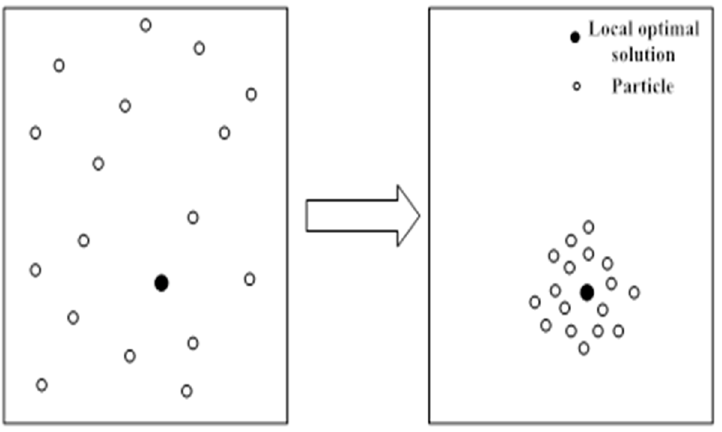
Figure 10. The PSO algorithm fell into the local optimal